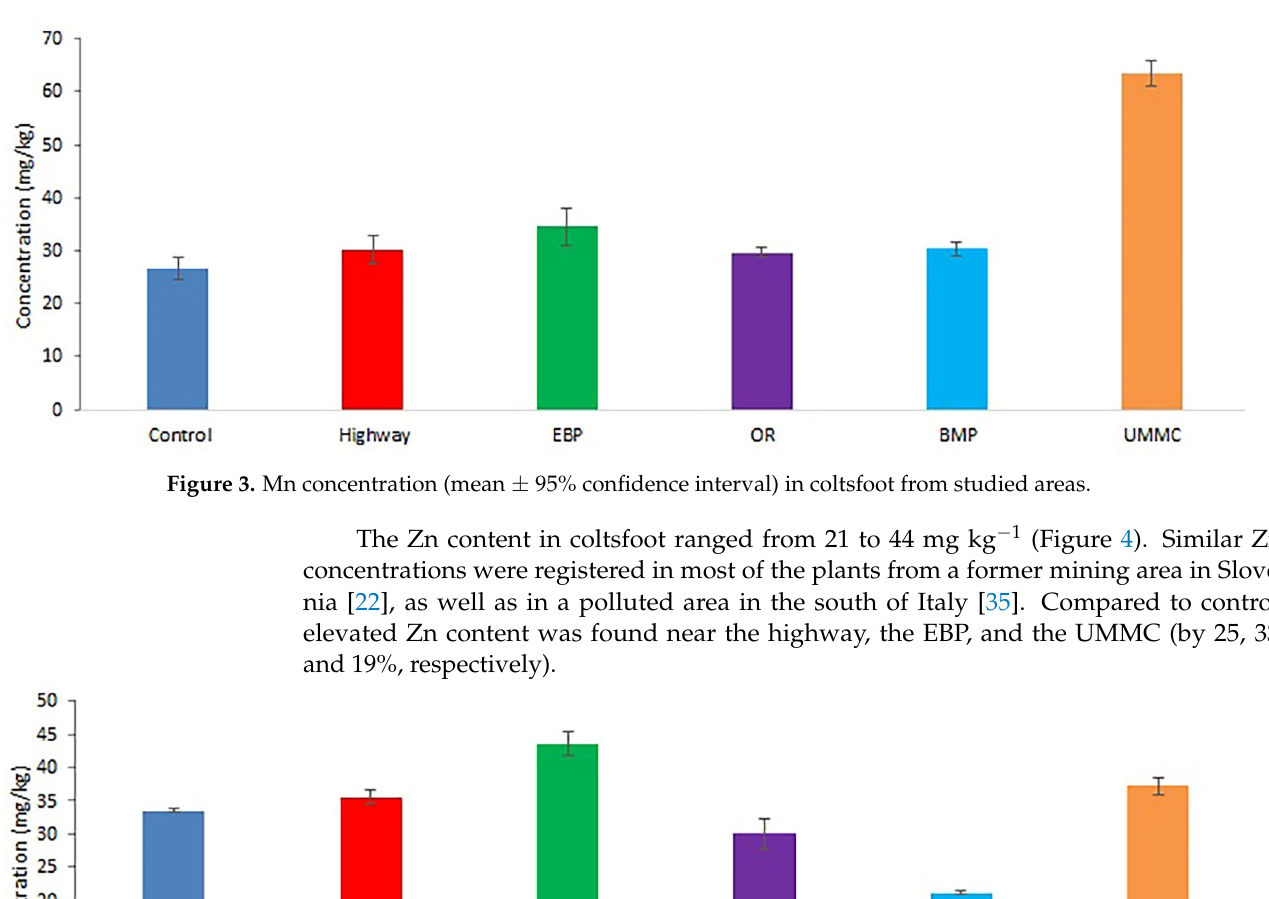
Figure 2. Fe concentration (mean ± 95% confidence interval) in coltsfoot from studied areas.